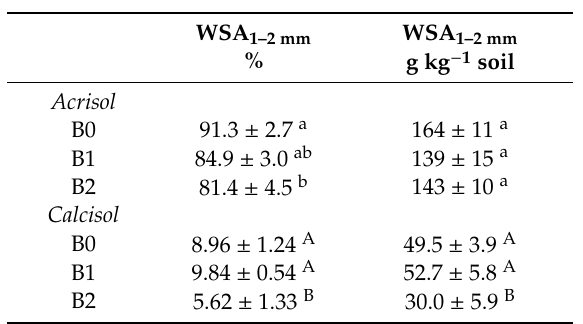
Table 3. Percentage of water stable aggregates (WSA 1–2 mm ) and content of WSA per kg soil. Mean ± standard error (n =